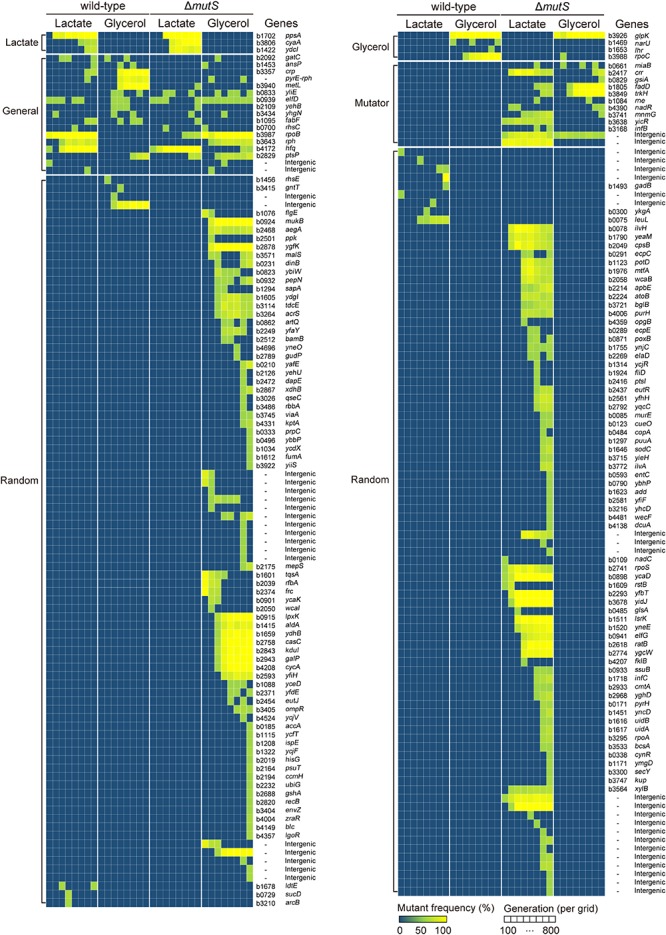
Whole genome resequencing analysis of ALE experiments. Dynamic illustration of the genotype space of the wild-type and the ΔmutS lineages in the course of ALE. Each grid on the X-axis represents ALE timescale at 100th generation intervals. The Y-axis outlines the mutations identified in the corresponding generation intervals which are clustered into subgroups-Lactate (lactate-specific), Glycerol (glycerol-specific), Mutator (mutator-specific) and Random. The mutations were grouped into five different categories – glycerol-specific, lactate-specific, generalist, mutator, and random – in accordance to their recurrence under specific selective pressures. The color gradient in the heat map depicts relative mutation frequency.